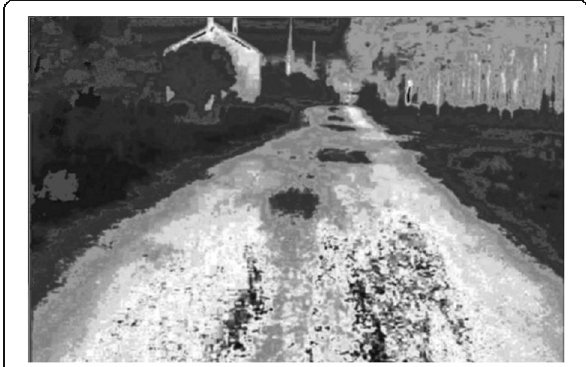
Fig. 12 Backprojection probability map of infrared